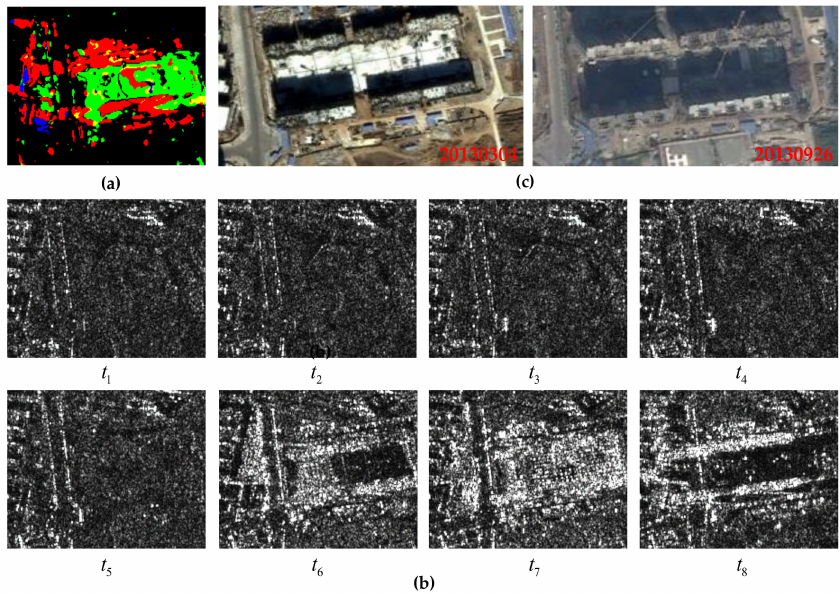
Figure 9. Change detection result of a representative sample in the realistic case: ( a ) The cropped change classification result; ( b ) The details of the change process across time within the cropped area; ( c ) Corresponding optical images (2013.03.04 and 2013.09.26) of the area.